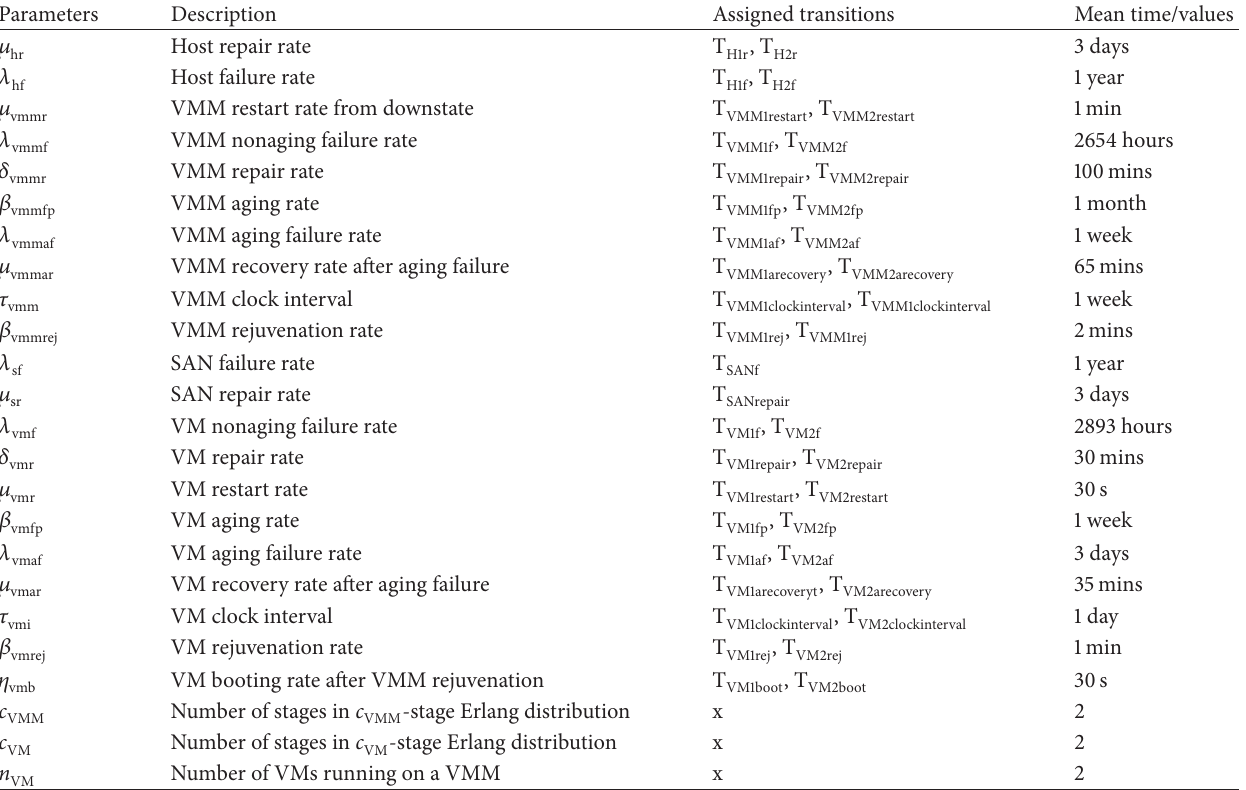
Table 3: Input parameter values used in the